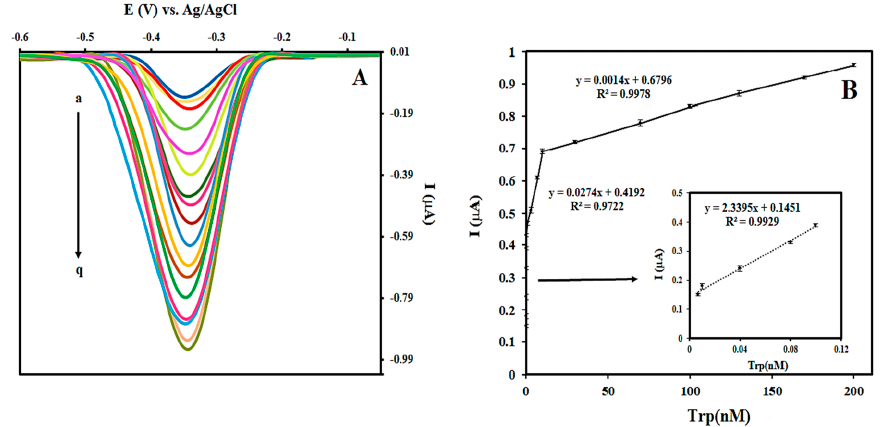
Figure 5. Sensitivity of the prepared aptasensor. ( A ) DPV signals of hemin/Apt/DGNs/Fe 3 O 4 @SiO 2 /DABCO/SPE with different Trp concentrations: (a) 0, (b) 0.007, (c) 0.01, (d) 0.04, (e) 0.08, (f) 0.1, (g) 0.3, (h) 0.9, (i) 3, (j) 7, (k) 10, (l) 30, (m) 70, (n) 100, (o) 130, (p) 170, and (q) 200 nM. ( B ) The calibration plots of I vs. Trp concentration.